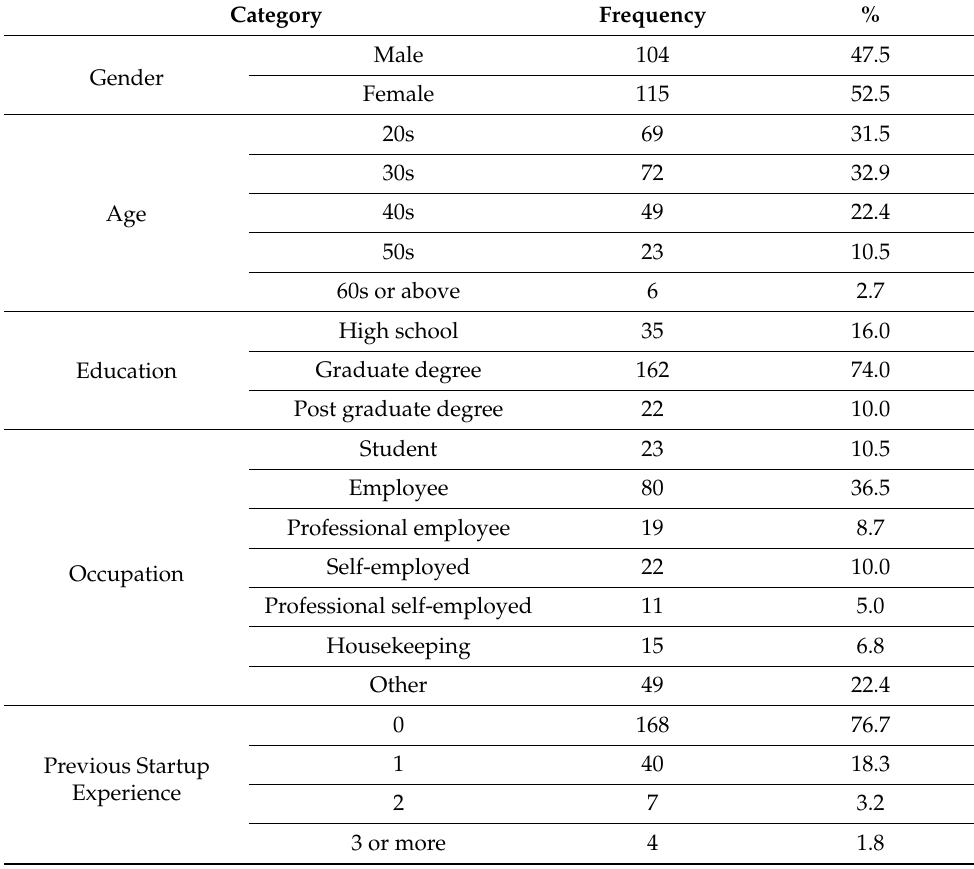
Table 1. Descriptive Statistics.